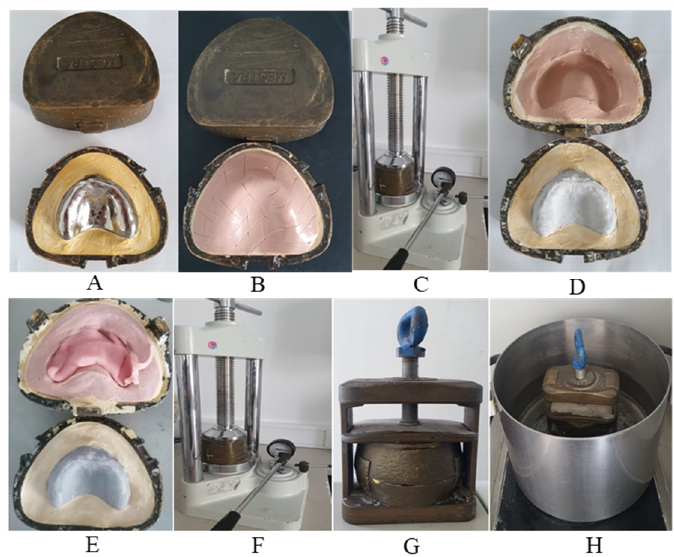
Figure 6. Thermopolymerizable acrylic bases fabrication. ( A ) Metal base in muffle; ( B ) silicone wall; ( C ) counter muffle closed with type III plaster; ( D ) mold of metal base; ( E ) placing the acrylic between the mold and the wall; ( F ) closing the muffle with the help of the press; ( G ) press used; ( H ) pan with hot water following the manufacturer’s time and temperature recommendations. 3.